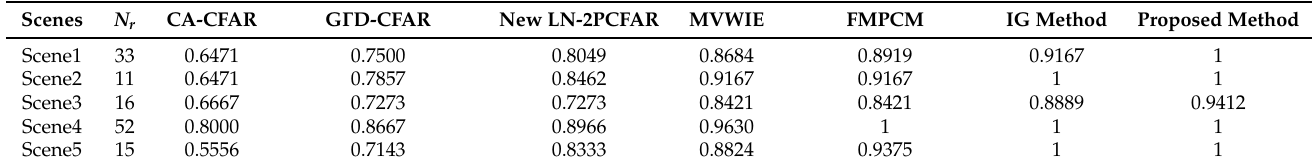
Table 3. FoM values of different